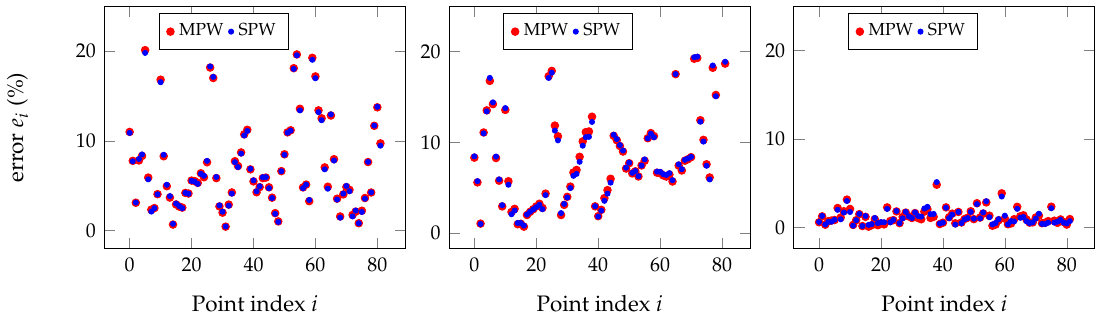
Figure 14. Root mean square (RMS) errors for SPW and MPW for the three sensors relatively to the reference sensor (RGB camera) for the raw point clouds with 82 points obtained in the setup from Figure 10.